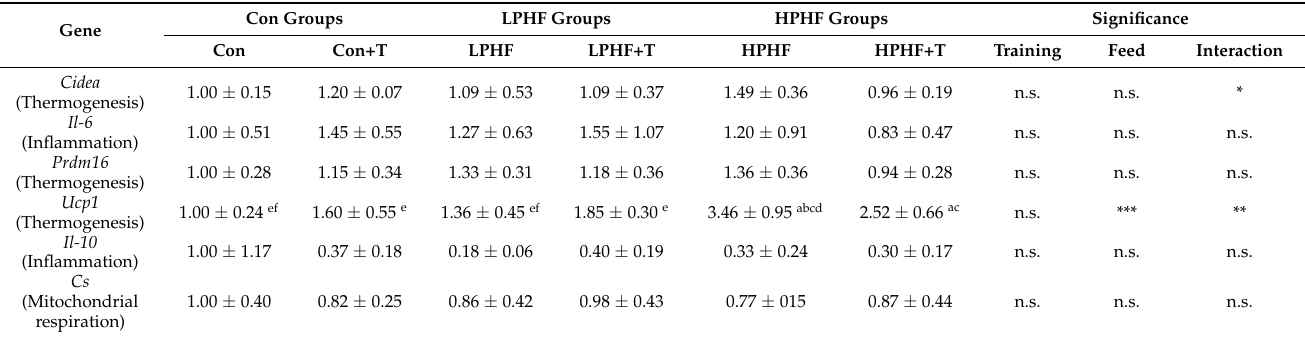
Table 6. Effects of LPHF, HPHF and/or training on BAT gene expression.